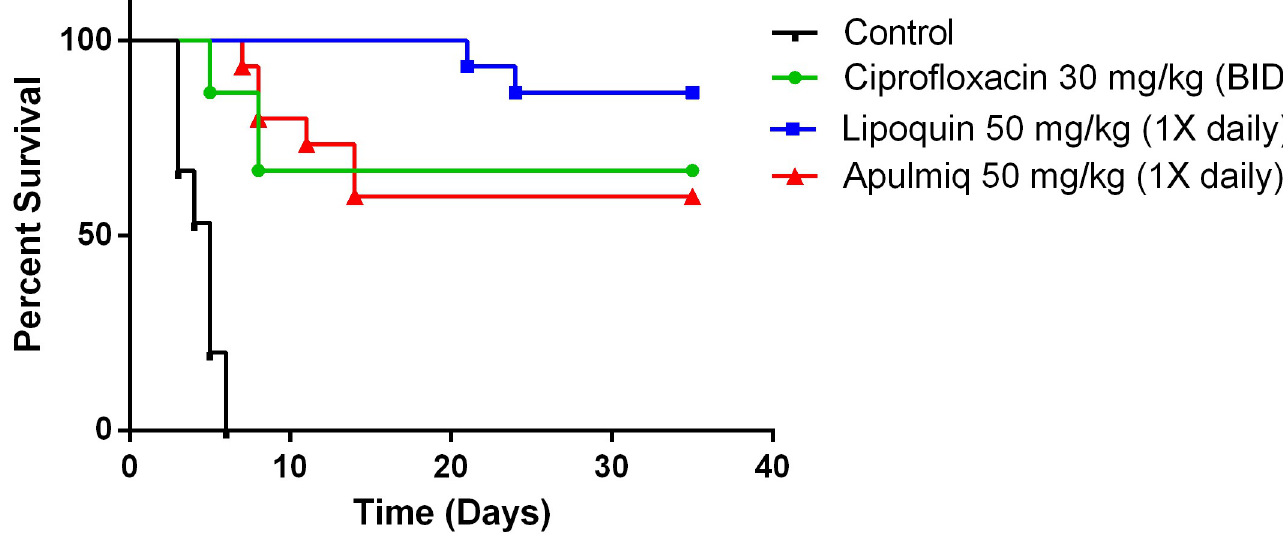
Fig 3. The efficacy of ciprofloxacin, lipoquin and apulmiq was evaluated in a post-exposure prophylaxis model after a lethal B . anthracis Ames challenge. Balb/c mice were challenged with 10 LD 50 of B . anthracis Ames, and were treated as described, 24 hours after exposure for three days. Efficacy of mice (n = 5x3) versus PBS-treated control mice. Therapeutic efficacy of intraperitoneal delivered ciprofloxacin (b.i.d.) and intranasal delivered apulmiq and lipoquin (once daily) were compared. All treatments improved survival compared to PBS (P < 0.001).